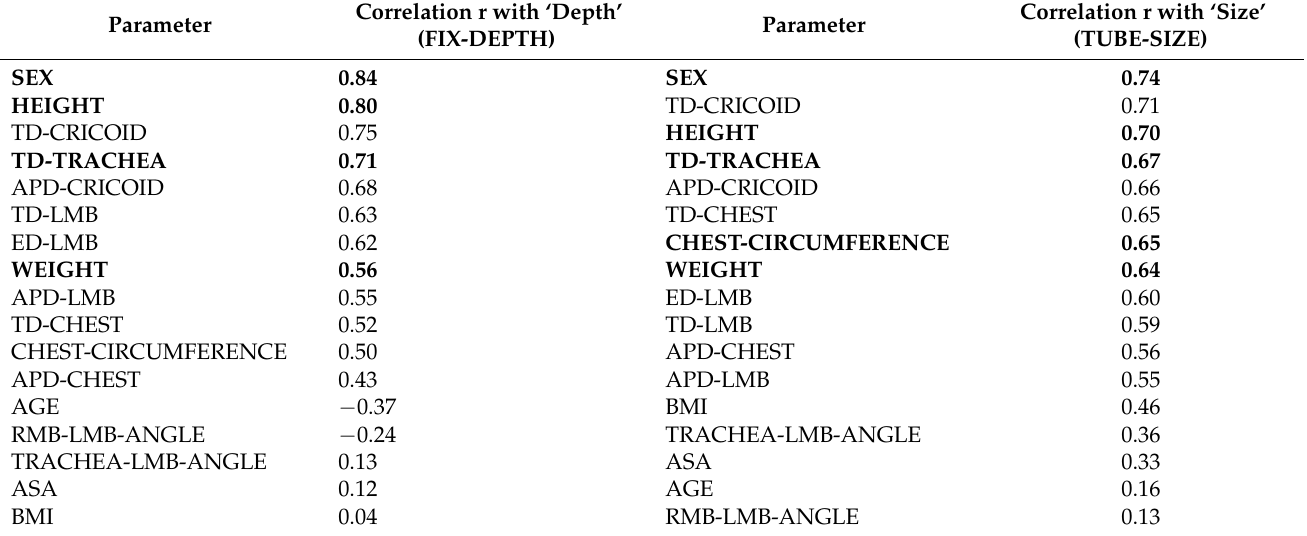
Table 5. Correlation coefficient (r) of 17 individual body parameters against their ’depth’ or ‘size’ values ( n = 231 subjects), ordered from high r down to low r. The parameters (4 for ‘depth’ and 5 for ‘size’) we identified for modeling are marked in bold letters.